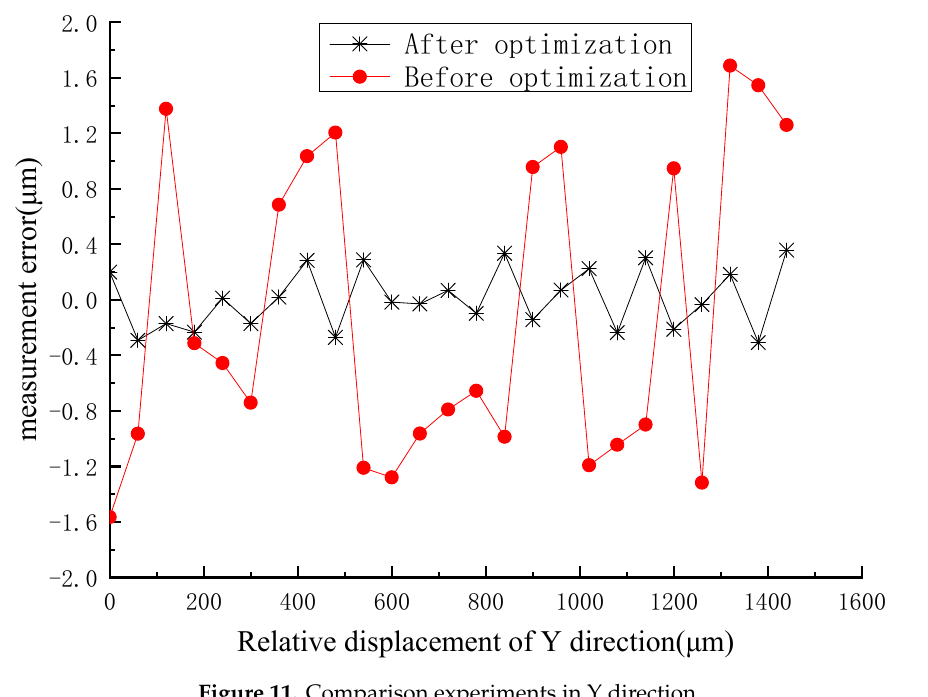
Figure 11. Comparison experiments in Y direction.